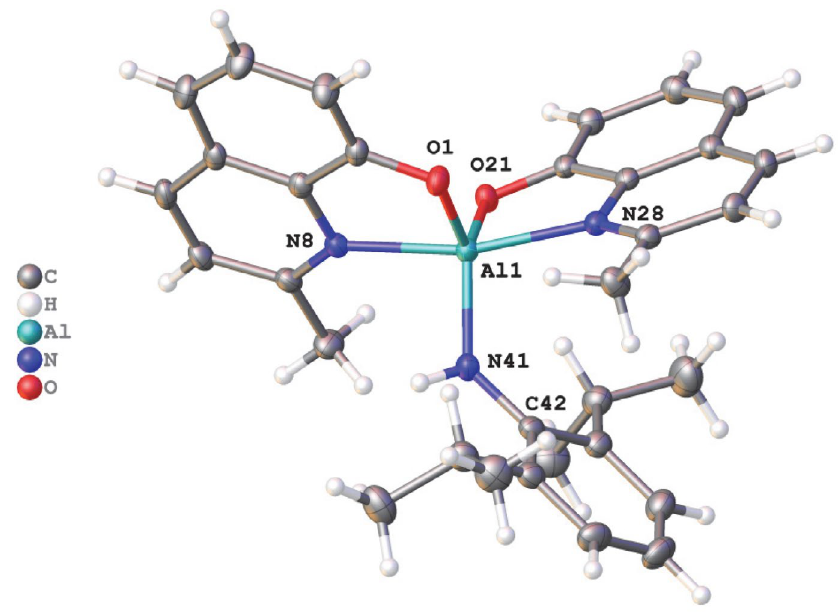
Figure 3. Thermal ellipsoid plot of